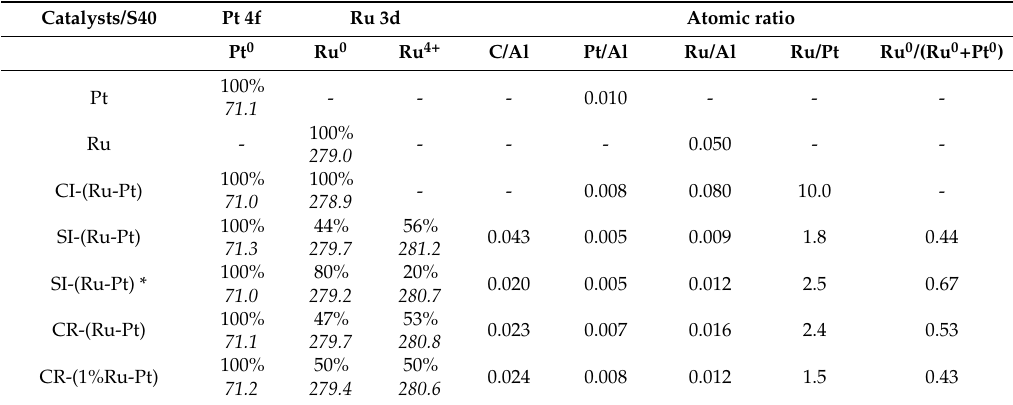
Table 2. XPS data of the Ru–Pt/S40 bimetallic catalysts prepared by co-impregnation (CI), successive impregnations (SI) or catalytic reduction deposition (CR), and of the corresponding monometallic samples: atomic percentages (%) and binding energies ( BE in eV ) of the Pt 4f and Ru 3d components and surface atomic